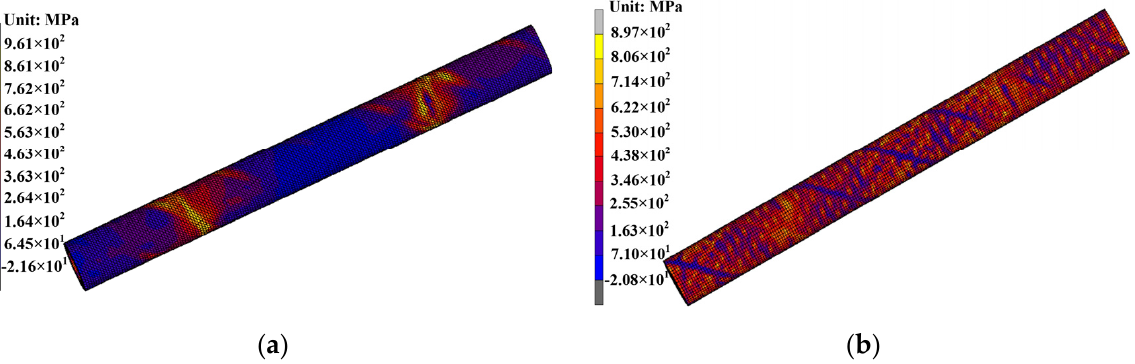
Figure 11. Von Mises stress distribution of the inner cylinder of the bolt (when the load reaches the maximum): ( a ) connected by merging nodes; ( b ) connected by gluing contact.